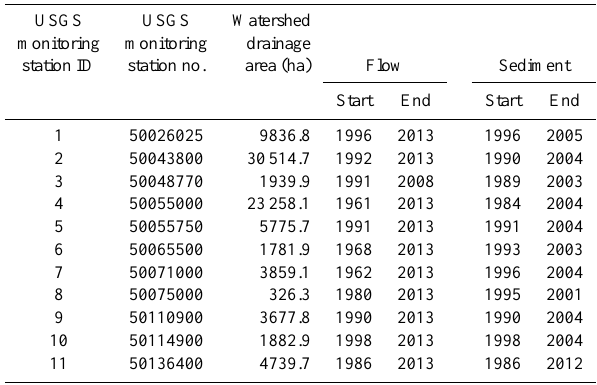
Table 1. Independent USGS monitoring stations, size of the mon- itored watershed, and time period for available flow and sediment